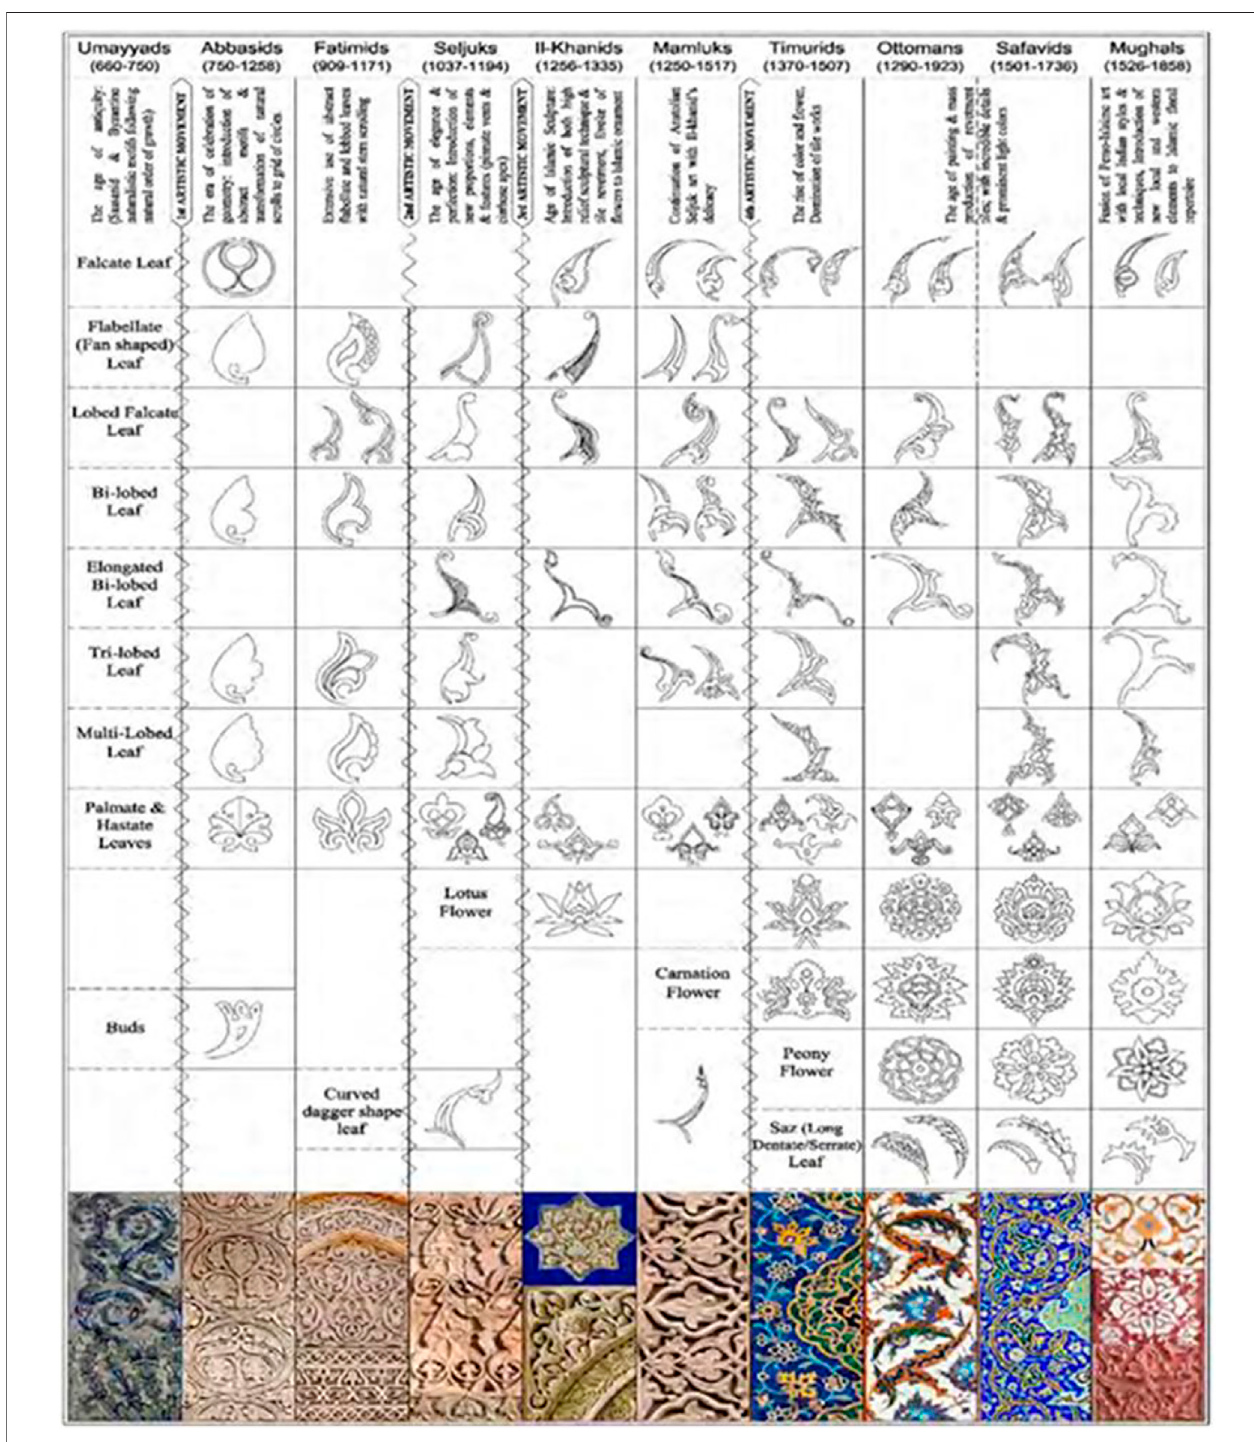
FIGURE 8 | Evolution of the main elements of Islamic fl oral ornamentation.